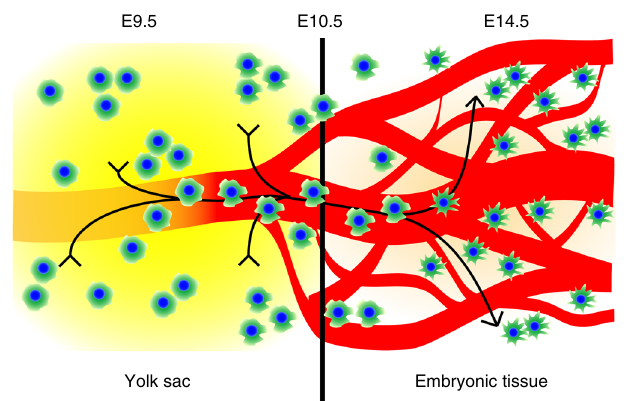
Fig. 8 YS-derived macrophages traf fi c during de fi ned stages of development. Graphical summary of morphology-dependent traf fi cking dynamics: macrophage progenitors expand in the YS from E8.5 onwards. They traf fi c to embryonic organs via vascular routes during a restricted time frame until E14.5. This traf fi cking period is characterized by a spherical cell shape. Along with progressive macrophage maturation an increasing amount of dendrites is formed and macrophages lose